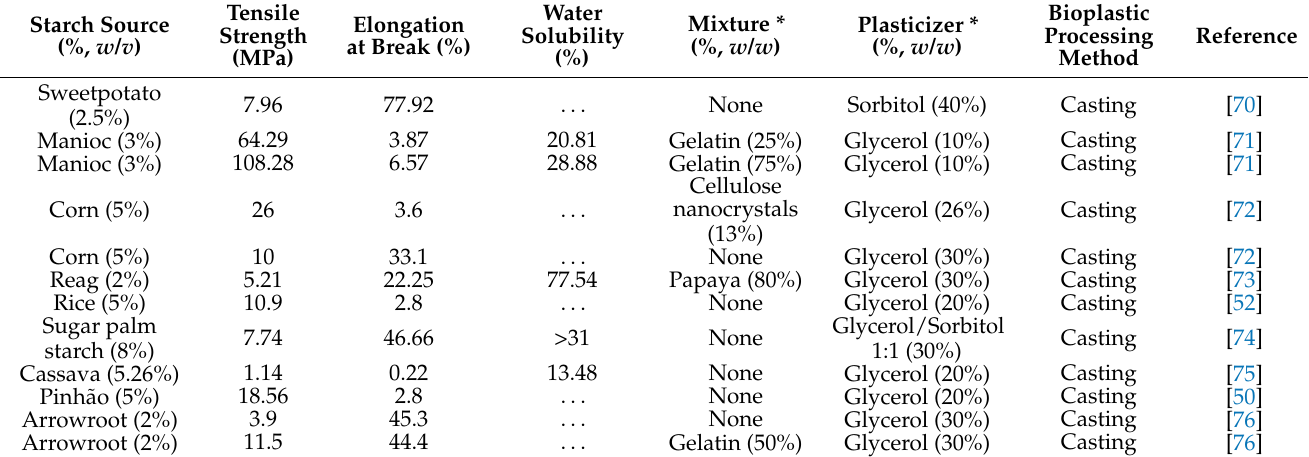
Table 1. Production and properties of starch-based